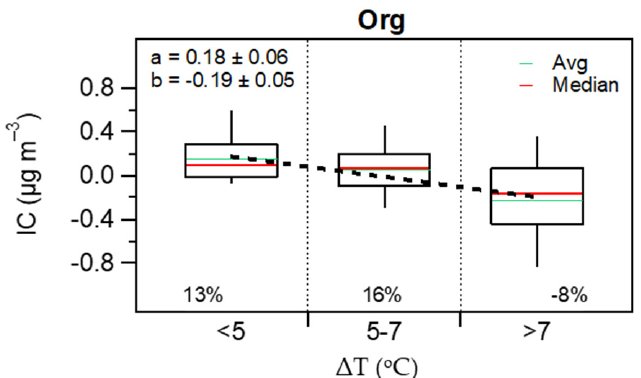
Figure 13. Indoor contributions of Organics as a function of indoor-outdoor temperature differences. The boxes and whiskers (bottom to top) represent the 10th and 25th percentiles, median (red line), and the 75th and 90th percentiles. Green lines represent average IC. Percentages correspond to the relative indoor contribution (RIC = IC/OC) for each bin.